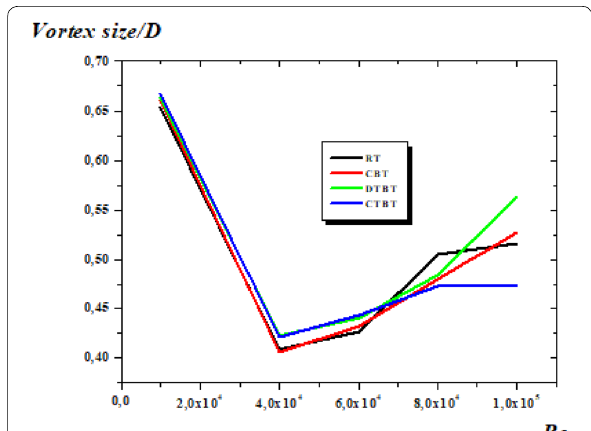
Table 3 Power number of different agitator’s types of tanks with and without baffles Agitators